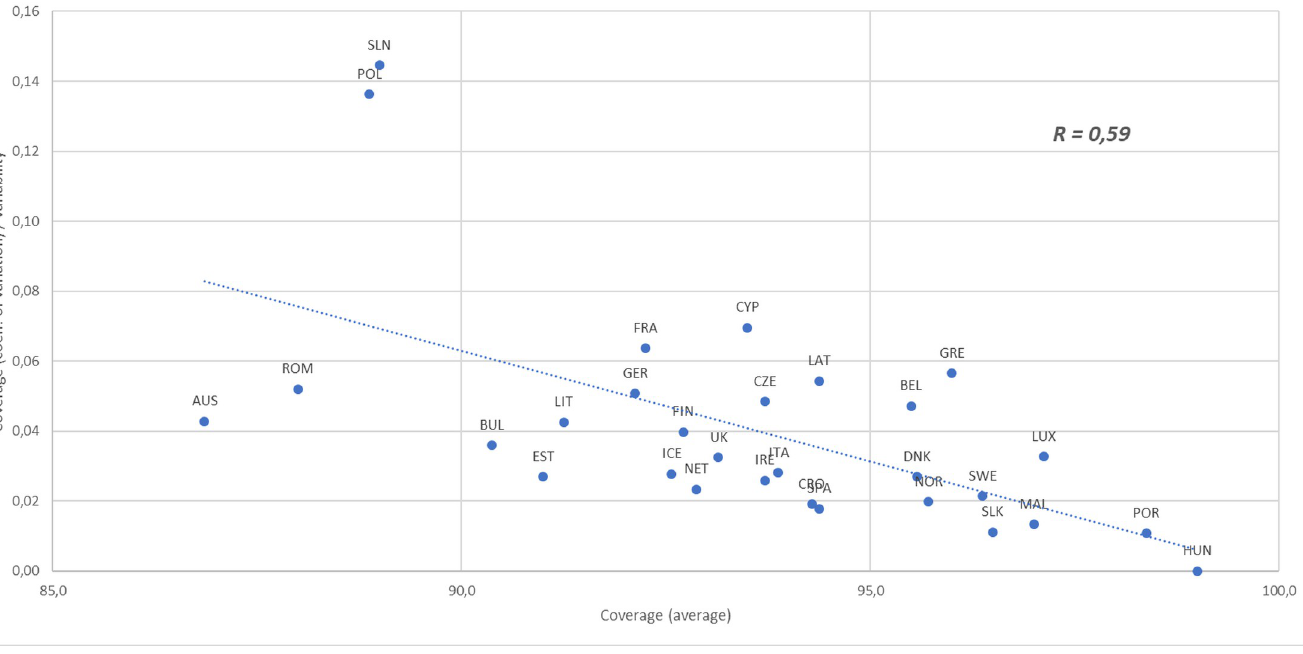
PLOS ONE | https://doi.org/10.1371/journal.pone.0271290 August 3,